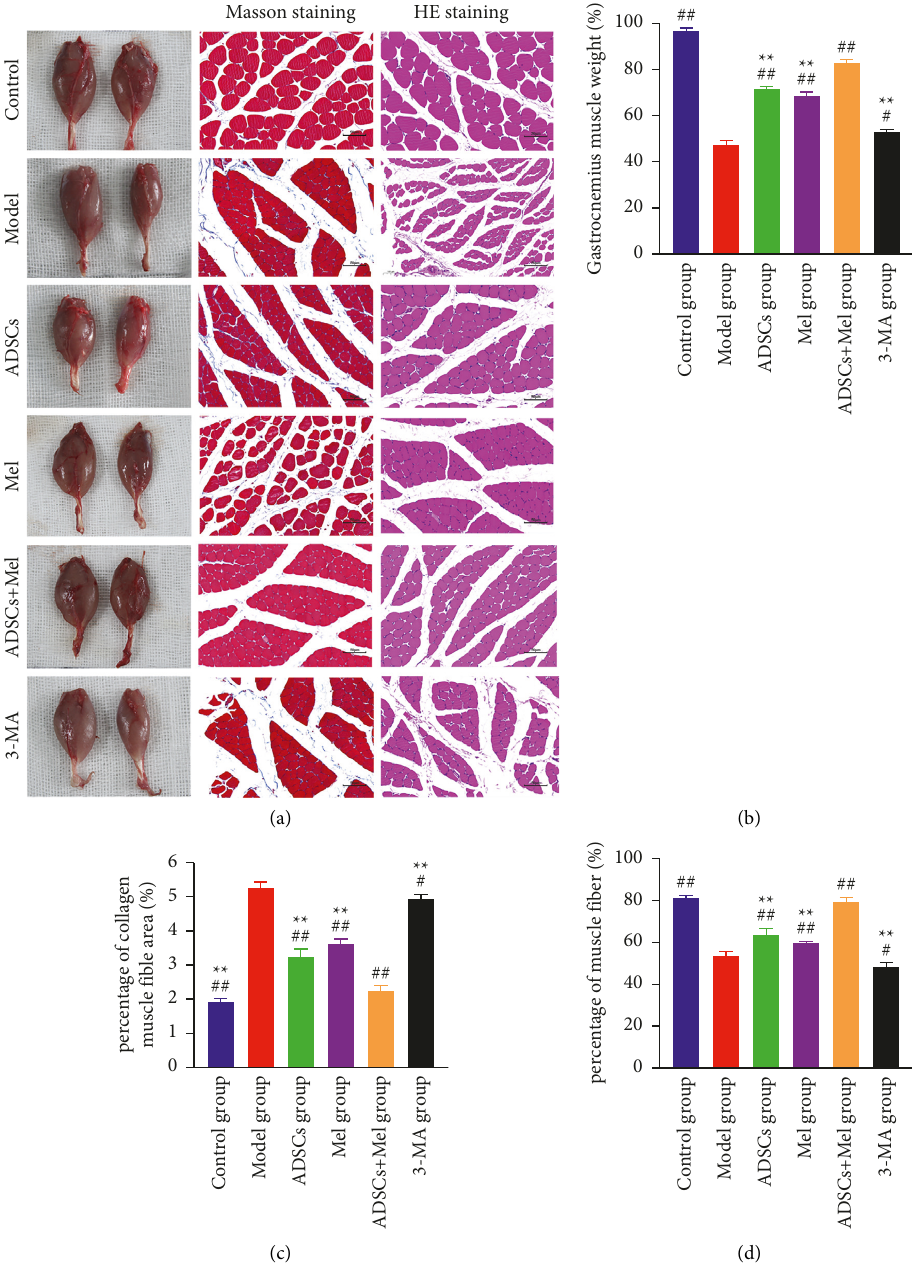
Figure 11: Histological assessment of the gastrocnemius muscle. (a) Image of the normal and surgical side of the gastrocnemius, Masson trichromatic staining, and H&E staining of the cross-section of the gastrocnemius. Scale bar � 50 μ m. (b) Gastrocnemius wet weight ratio. (c) The average percentage of collagen fiber area. (d) Muscle fiber cross-sectional area statistical results. The control group, ADSCs group, Mel group, ADSCs+Mel group, and 3-MA group were compared with the model group, respectively. Each value is the mean ± SE of five independent determinations. ## P < 0 . 01 and # p < 0 . 05 compared with the model group; ∗∗ p < 0 . 05, the control group, ADSCs group, model group, Mel group, ADSCs+Mel group, and 3-MA group were compared with the ADSCs+Mel group; scale bar � 20 μ